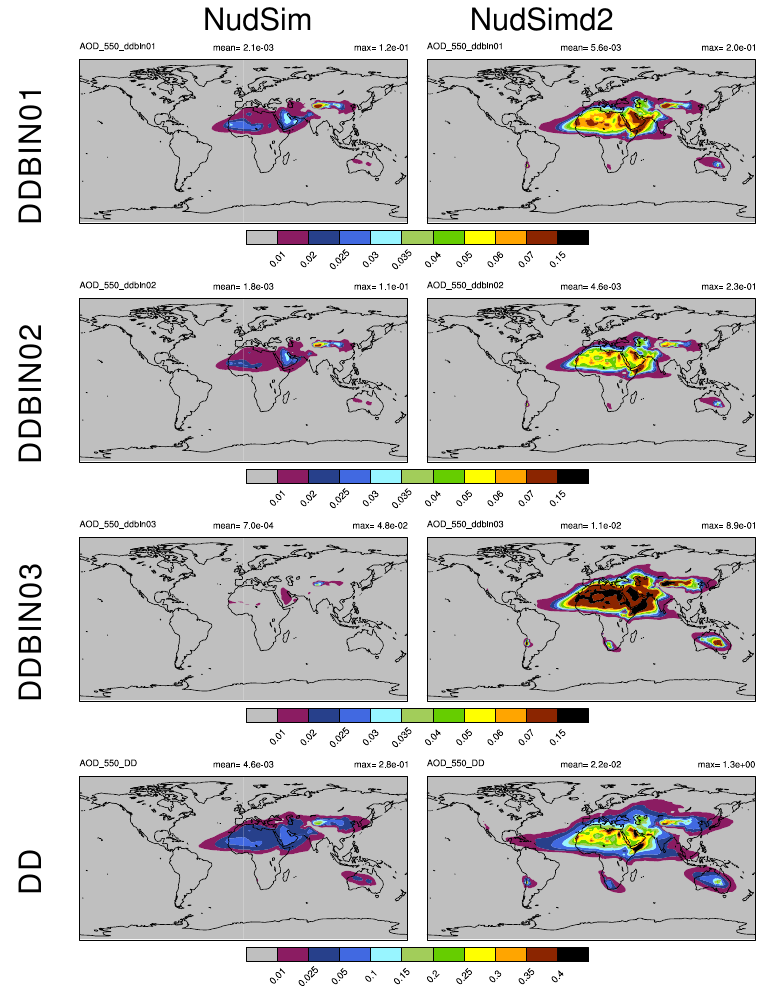
Figure 4. Mean 2004 dust AOD for the NudSim (first column), and the NudSimd2 (second column) simulations, for the three dust bins, from the smallest (first row) to the largest (third row), and total DD AOD in fourth row.